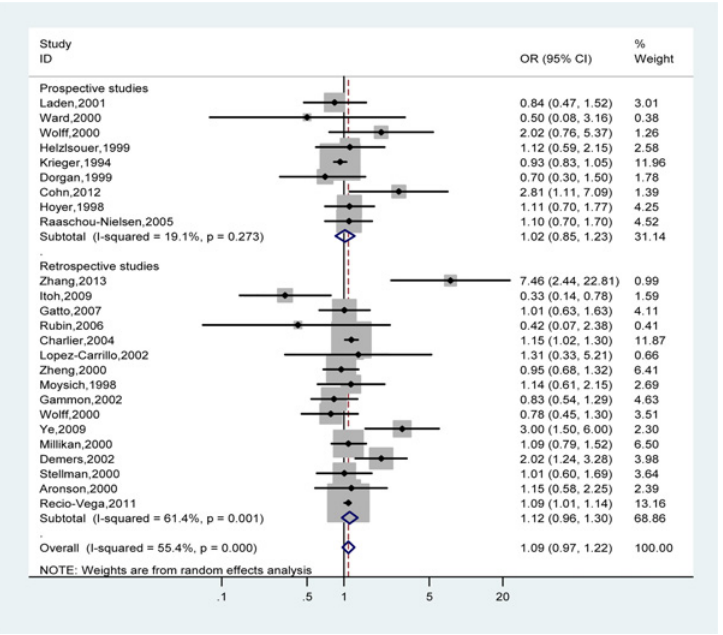
Fig 2. Forest plot describing the association between total PCB exposure and breast cancer risk. Apart from the overall analysis, the subgroup analyses on prospective (upper panels) and retrospective (lower panels) studies are presented.